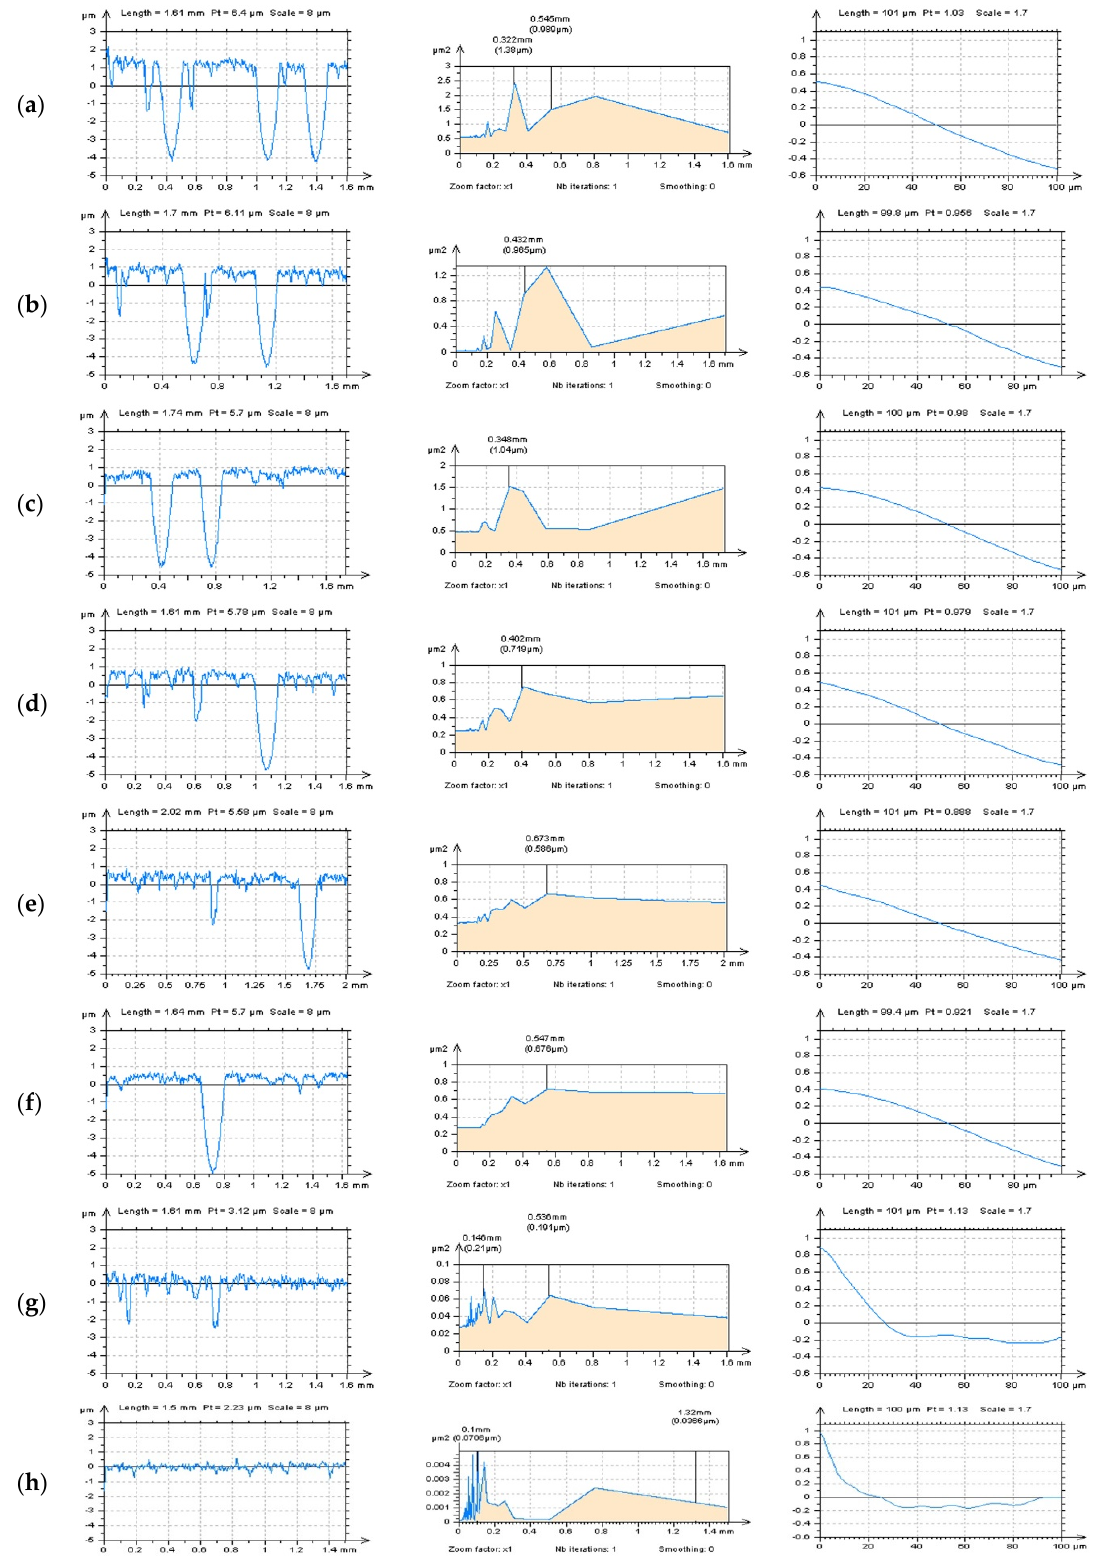
Figure 8. Profiles (left column), their PSDs (center) and ACFs (right column), received from stylus measured, the plateau- honed cylinder liner surface with the following number of features: three dimples ( a ), two dimples and one scratch ( b ), two dimples ( c ), one dimple and two scratches ( d ), one dimple and one scratch ( e ), one dimple and no scratches (f), two scratches but no dimples ( g ) and no dimples and no scratches ( h ) profile.